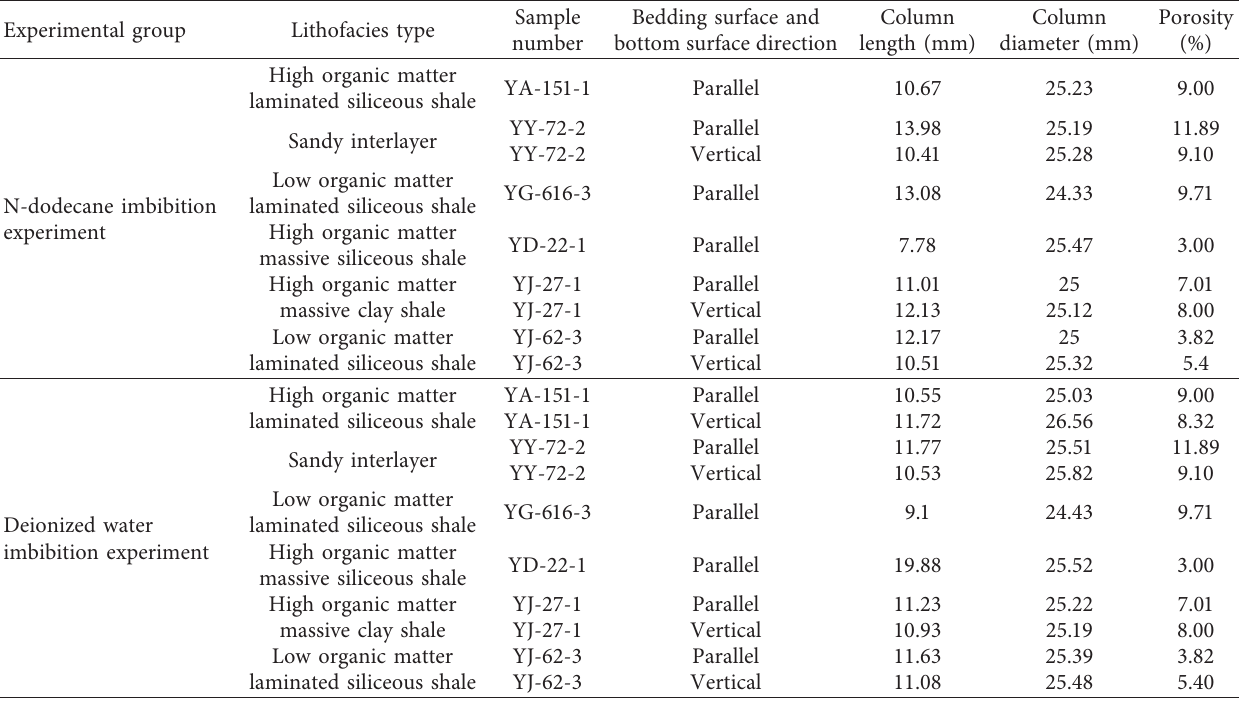
Table 2: Spontaneous imbibition sample